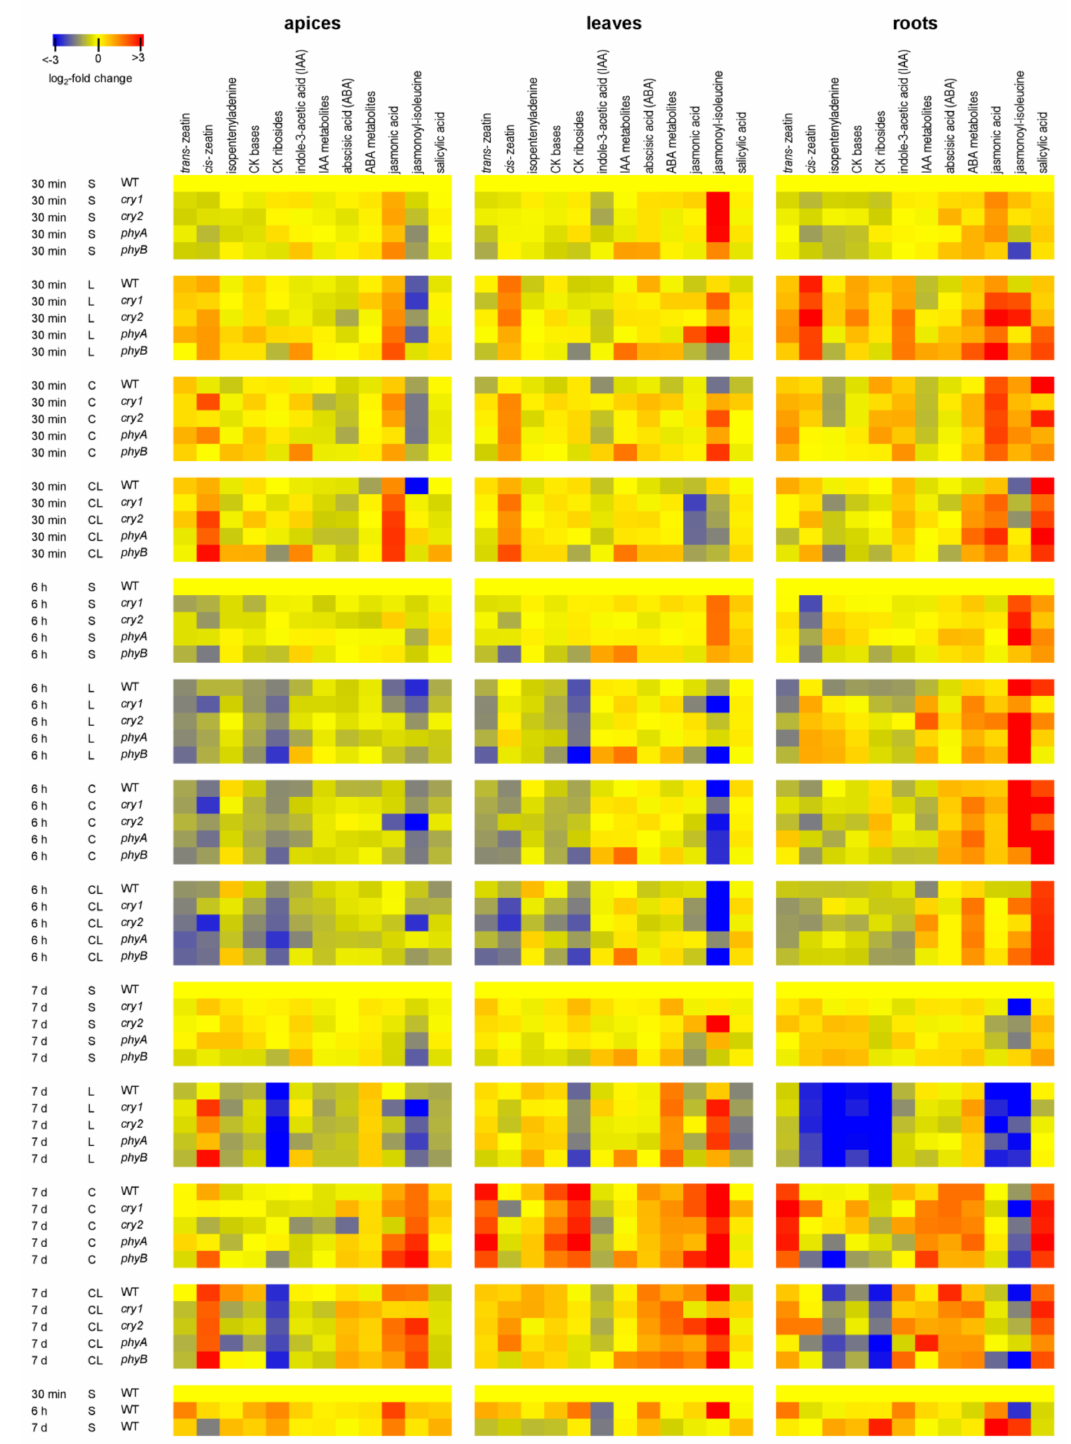
Figure 3. Heatmap of changes in phytohormone levels determined in shoot apices, leaves and roots of plants exposed to standard (S), low light (L), cold (C) and combined cold and low light (CL) conditions for 30 min, 6 h or 7 d. Four independent biological samples were evaluated. Data in the heatmap are normalised to WT levels in S conditions separately for each tissue and time point (the colour code shows relative changes in log 2 ). Means ± SD and other statistics are shown in Table S2. Cytokinin (CK) bases ( trans -zeatin, cis -zeatin, isopentenyladenine); CK ribosides ( trans -zeatin riboside, dihydrozeatin riboside, cis -zeatin riboside, isopentenyladenosine); indole-3-acetic acid (IAA) metabolites (indole-3-acetic acid aspartate, indole-3-acetic acid glucosyl ester, oxo-indole-3-acetic acid, oxo-indole-3-acetic acid glucosyl ester); abscisic acid (ABA) metabolites (phaseic acid, dihydrophaseic acid, 9-hydroxy-abscisic